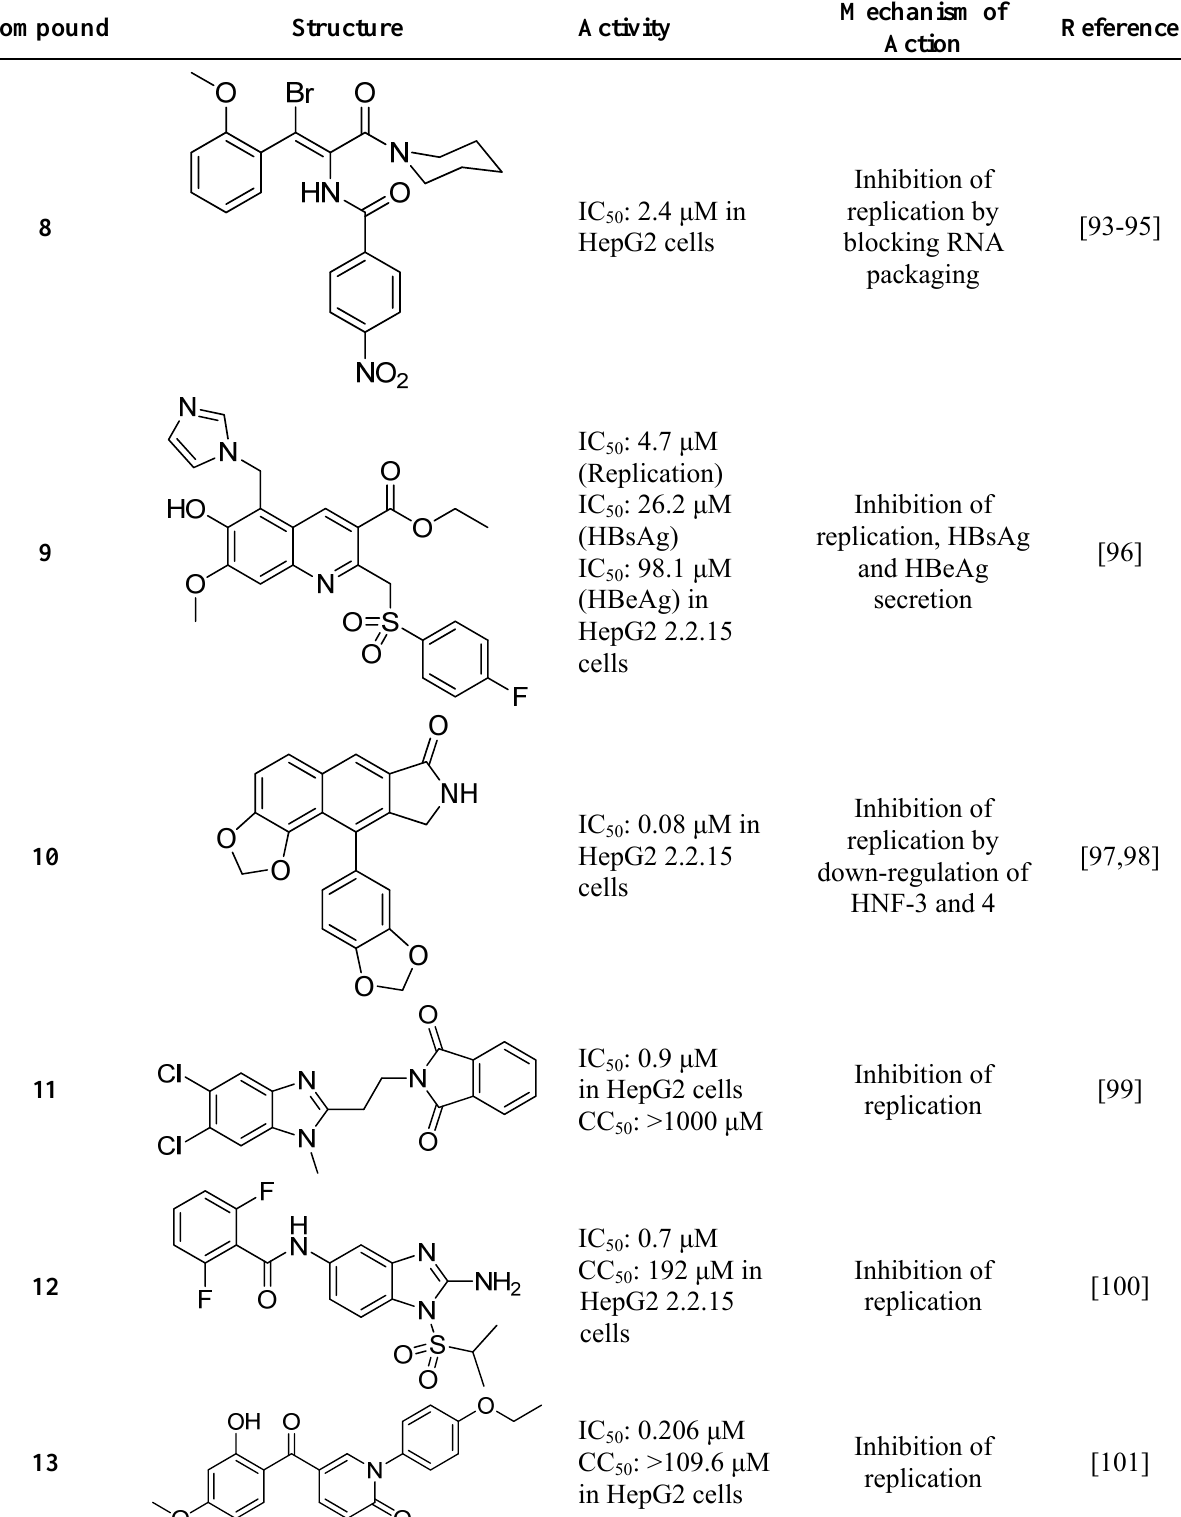
Table 4. Summary of non-nucleoside HBV inhibitors that target viral replication.